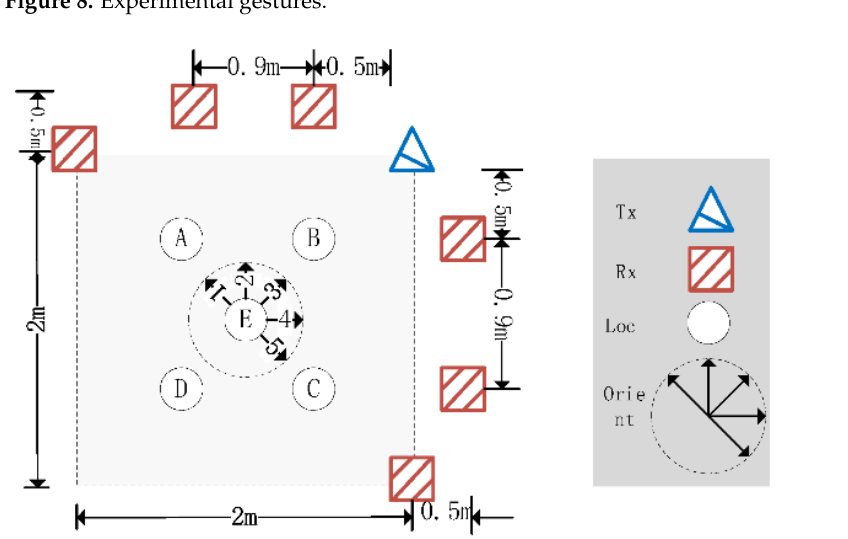
Figure 8. Experimental gestures.